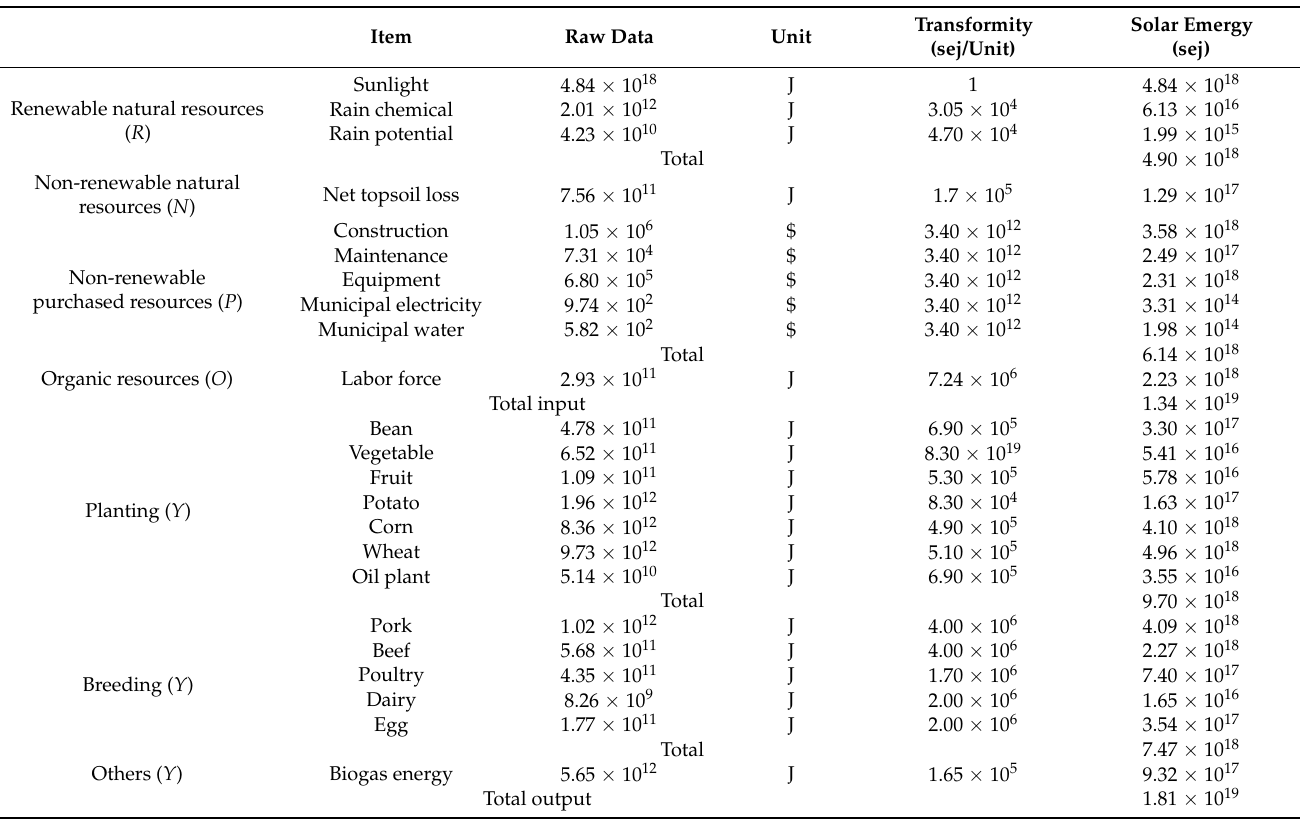
Table 4. Emergy input and output of the cluster